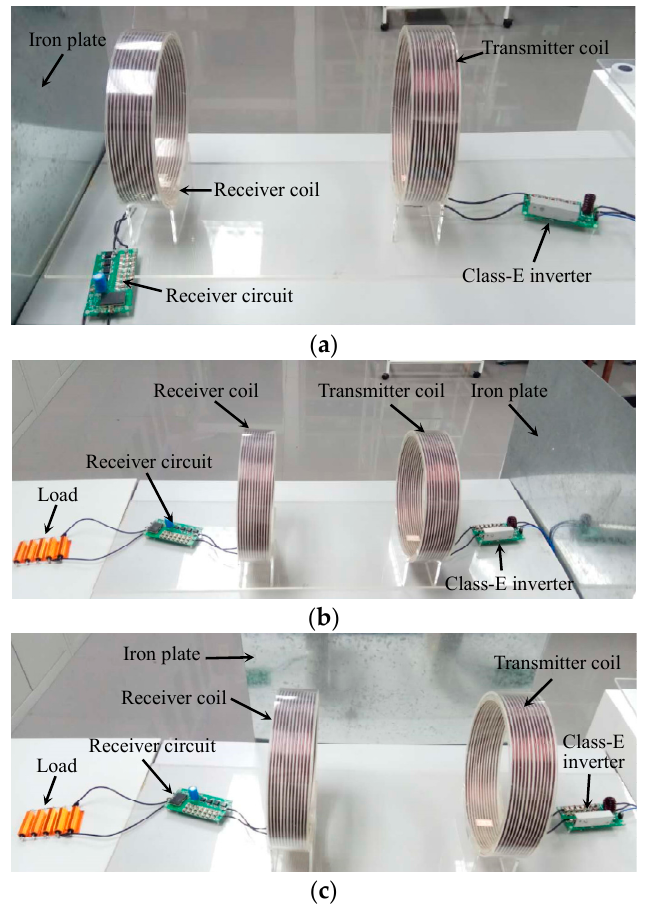
Figure 14. Experimental prototype of WPT system and demonstration of different positions of the iron plate. ( a ) At the receiver side; ( b ) at the transmitter side; ( c ) at the outer side of the two coils.